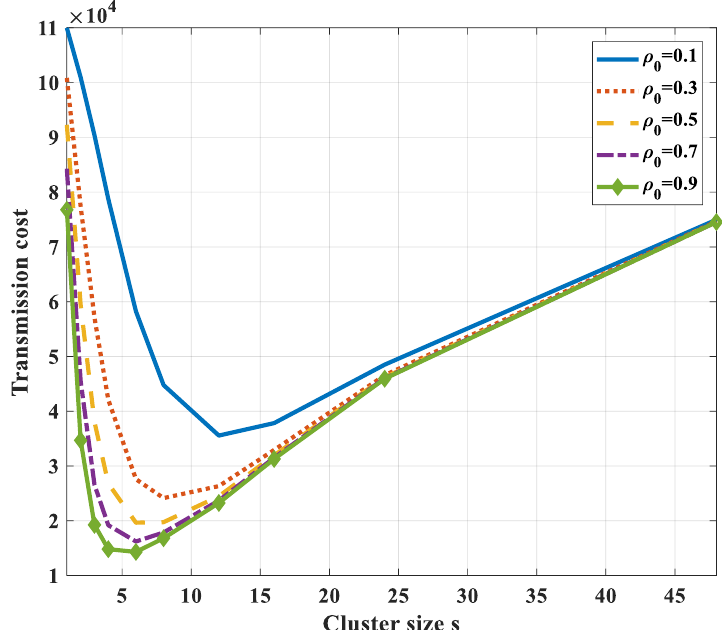
Figure 17. Total transmission cost, respectively, to cluster size with different values of the entropy correlation coefficient with compression at the cluster head only.